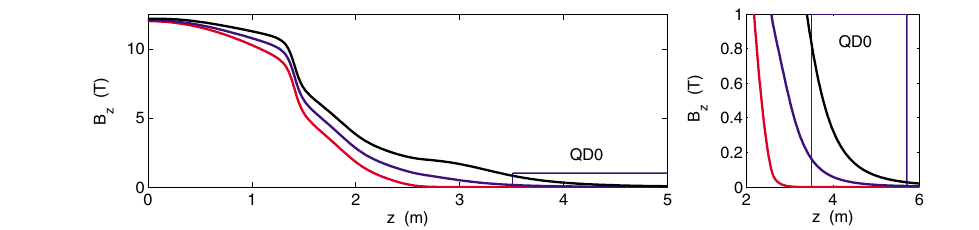
FIG. 7. (Color) Tiny detector with small additional field giving 0.1 or 0.5 T m integrated over FD (indicated as ‘‘Tiny (cid:1) ! ’’ in Table I). IP is at z (cid:3) 0 m . ‘‘Tiny (cid:1) ! 2